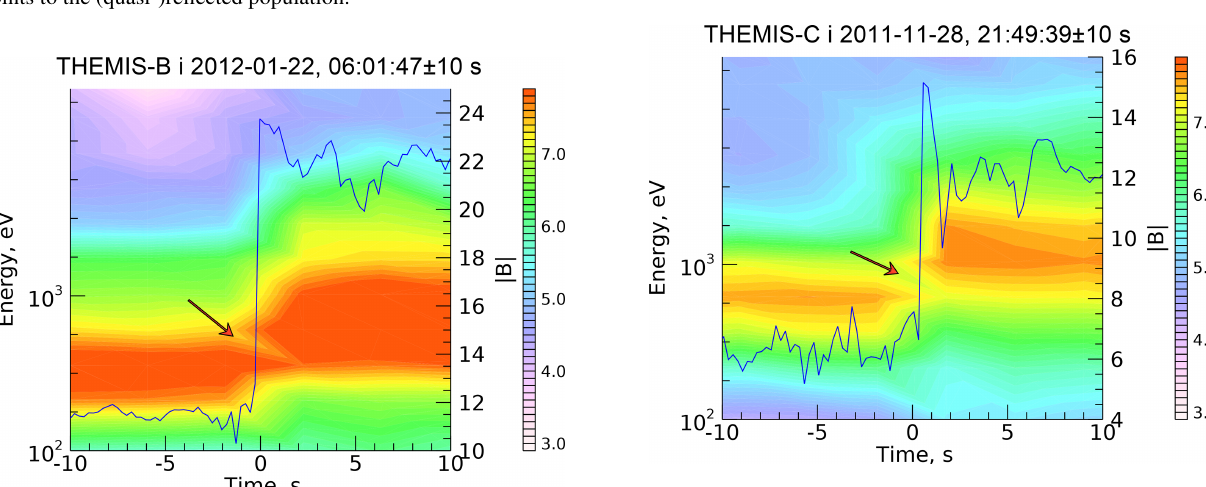
Figure 8. (a) The modeled (blue) and the predicted (red) magnetic profiles as well as the ion orbits x vs. v x . (b) A slice of the ion distribution inside the ramp. The shock parameters are M = 2 . 1, θ = 65 ◦ , R = 1 . 85, β i = 0 . 4, β e = 0 . 35, and s = 0 . 4. The arrow points to the (quasi-)reflected population.